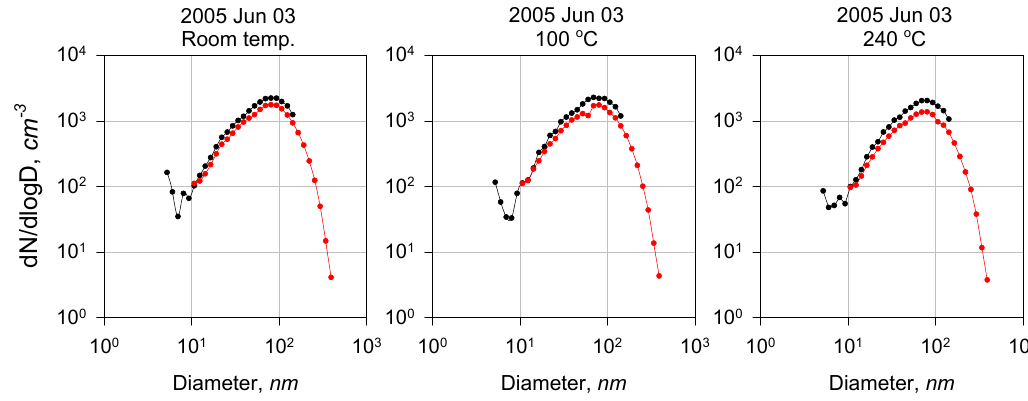
Fig. 6. Typical examples of aerosol size distribution measured on 3 June 2005 at Syowa Station, Antarctica at room temperature (ca. 20 ◦ C), 100 ◦ C and 240 ◦ C.